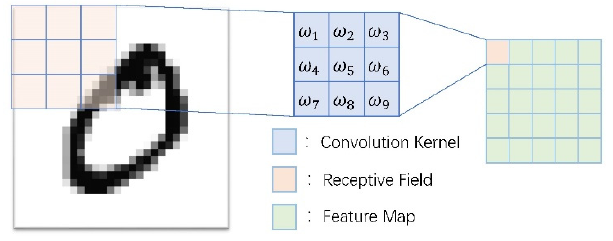
Figure 5. Convolution process of image.